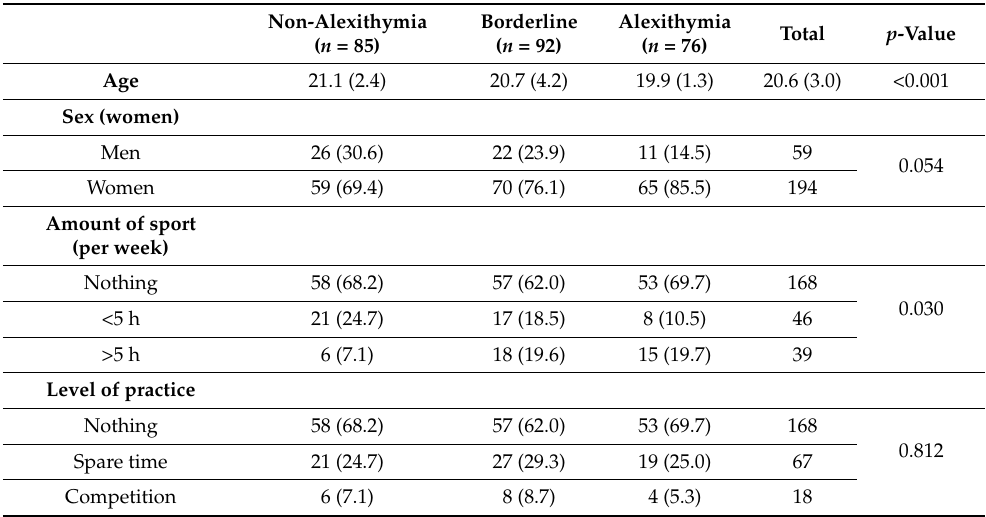
Table 2. Alexithymia and sport practice